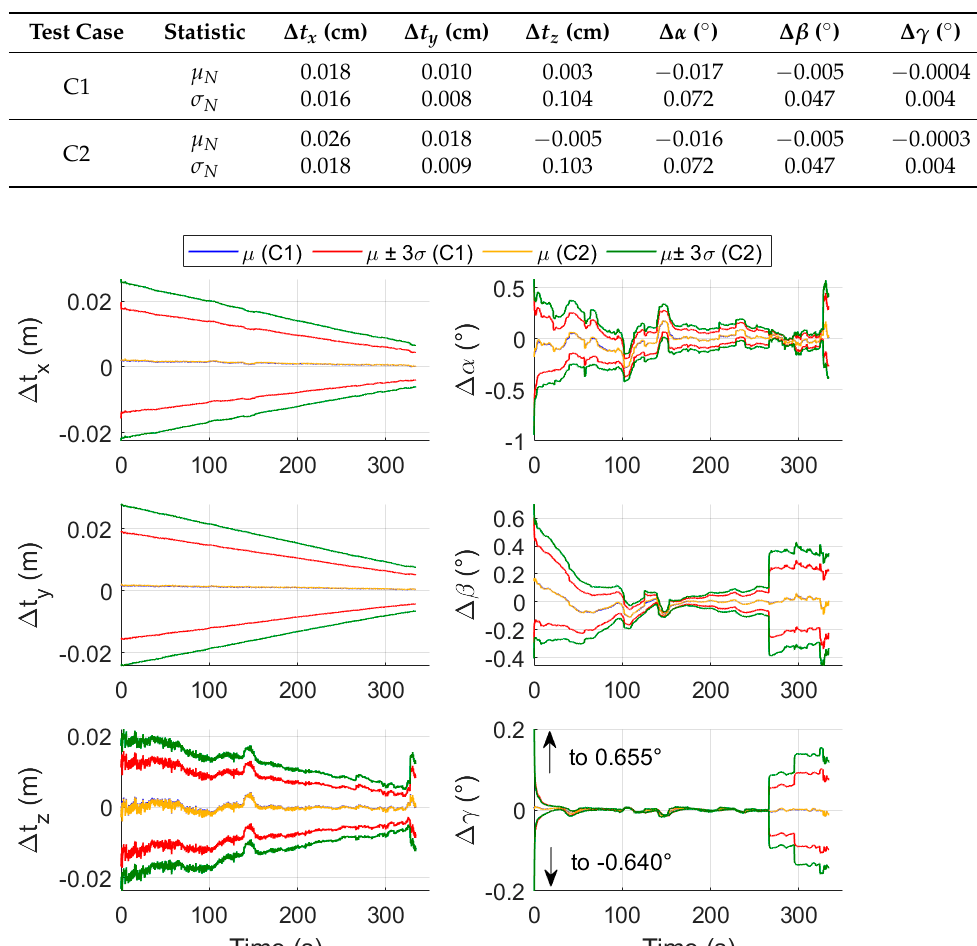
Table 15. Mean and standard deviation of the pose estimation errors for different levels of uncertainty in the knowledge of the intrinsic parameters of the camera for test cases C1 and C2.